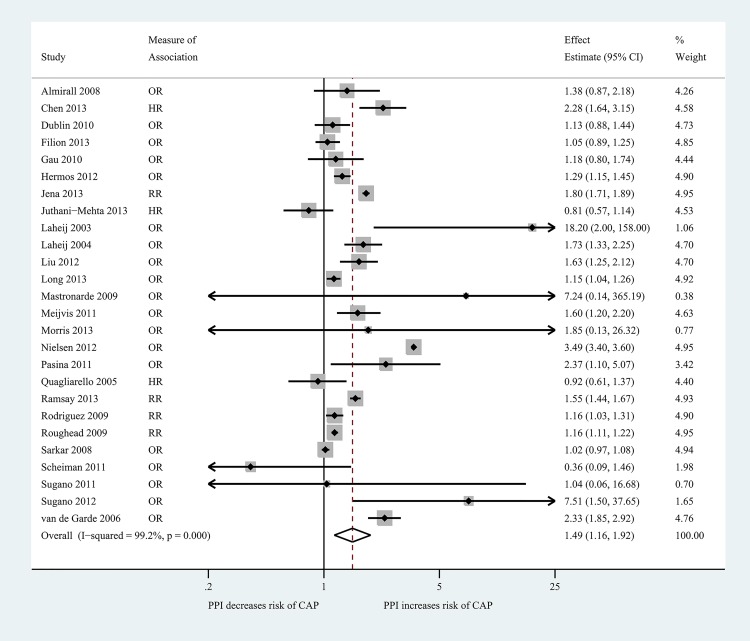
Summary Forest Plot of Overall Risk of Community-Acquired Pneumonia with Outpatient Proton Pump Inhibitor Use, subdivided by study design and effect estimate.Solid diamond represents effect estimate. Shaded box size is proportional to the weight of the study in the meta-analysis. Confidence intervals are denoted by horizontal lines, with arrows where confidence interval extends beyond figure. Vertical dashed line represents the null effect. The open diamond is centered at the summary effect estimate and proportional to the confidence interval.